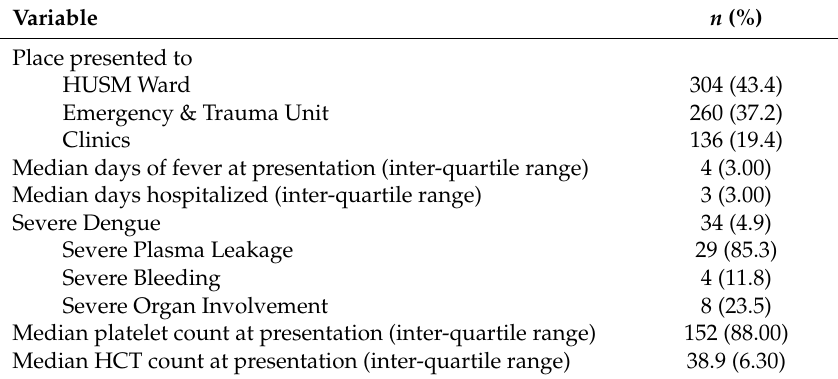
Table 3. Clinical characteristics of the patients ( n =